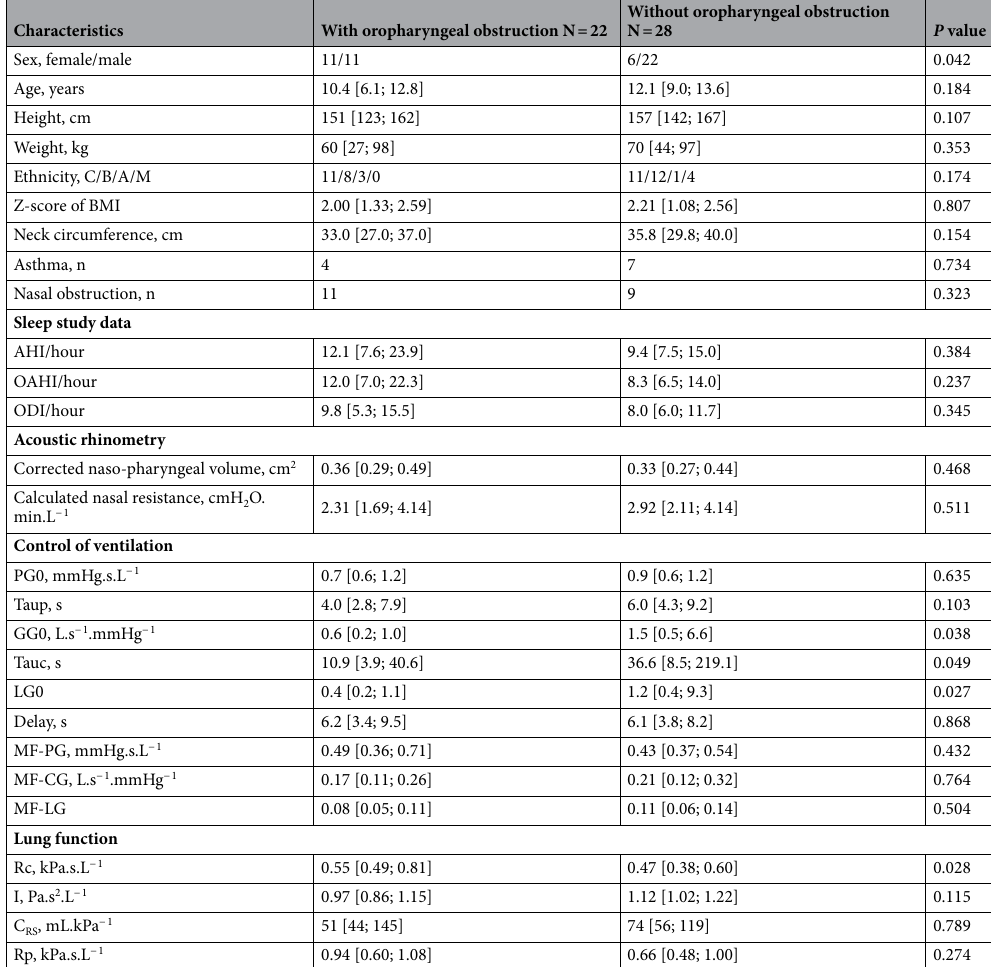
Table 2. Clinical characteristics, control of ventilation and lung function parameters according to the presence of oropharyngeal obstruction. Ethnicities are Caucasian/African/Asian/Mixed. P value stands for the comparison of groups with and without oropharyngeal